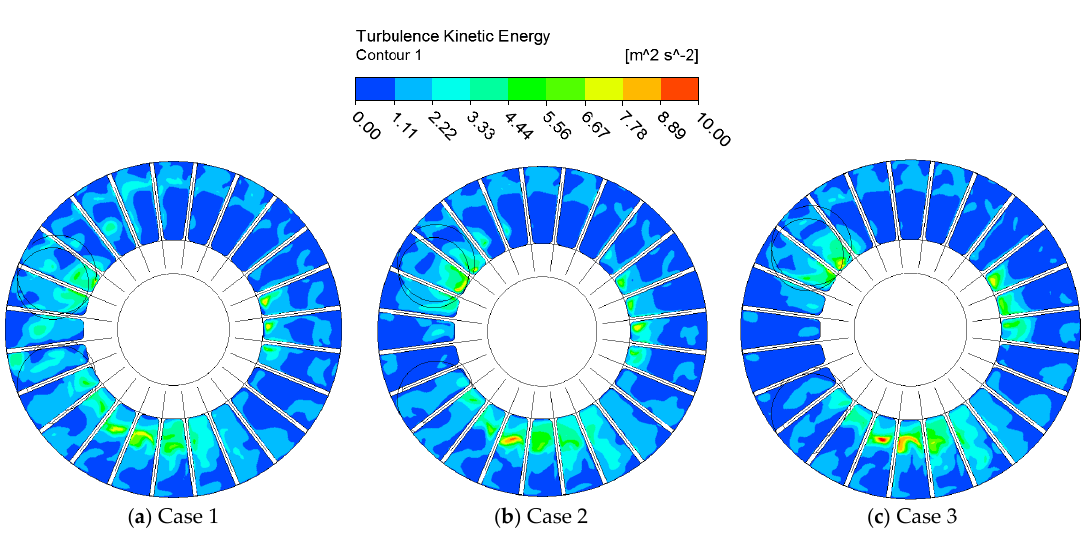
Figure 23. Velocity fluctuation intensity in side channel passage.